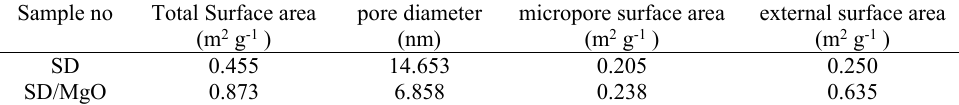
Table 2. Physical properties of the SD and SD/MgO nano-biocomposites. Table 2: Physical properties of the SD and SD/MgO